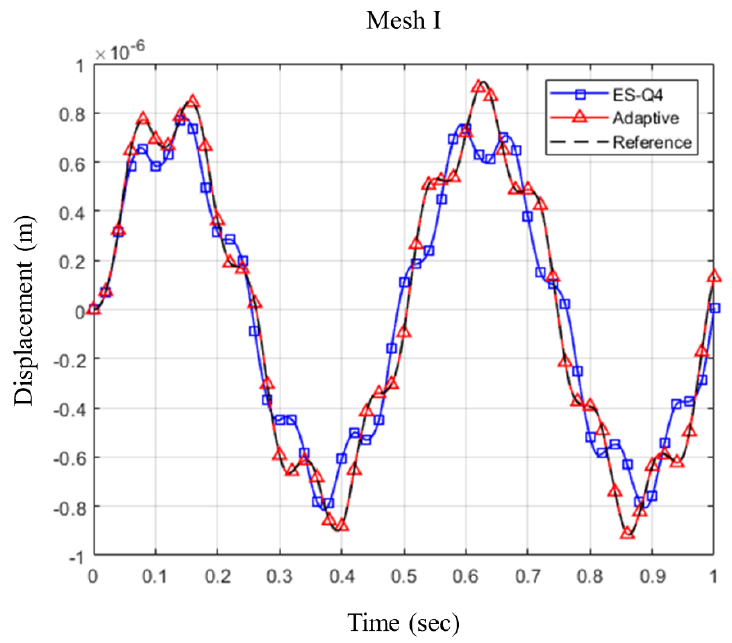
Figure 8. Transient response (displacement in y -direction) at the point A in the Cook’s skew beam problem. The edge-based smoothed four-node element (EN-Q4), and adaptive enrichment scheme for the edge-based smoothed element (adaptive) are used with Mesh I.